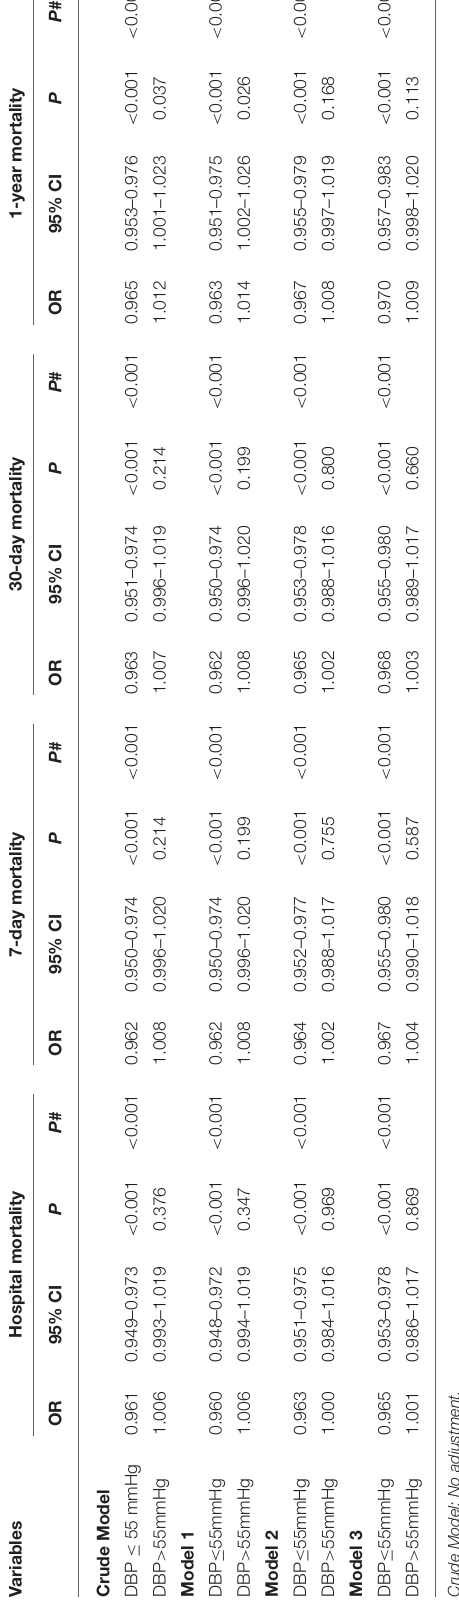
Medication Interestingly, as shown in Table 5 , in patients with MBP > 70 mm ( p = 0.021) modified the association between MBP and 1-year mortality. In patients with SBP > 110 mm Hg, nitrates modified the association between SBP and 1-year mortality ( p = 0.019). Furthermore, hypertension ( p = 0.002) and heparin ( p < 0.001) modified the association between DBP and mortality in patients with DBP ≤ 55 mm Hg ( Table 6 ). CHF ( p = 0.046) and hypertension ( p = 0.025) modified the association between